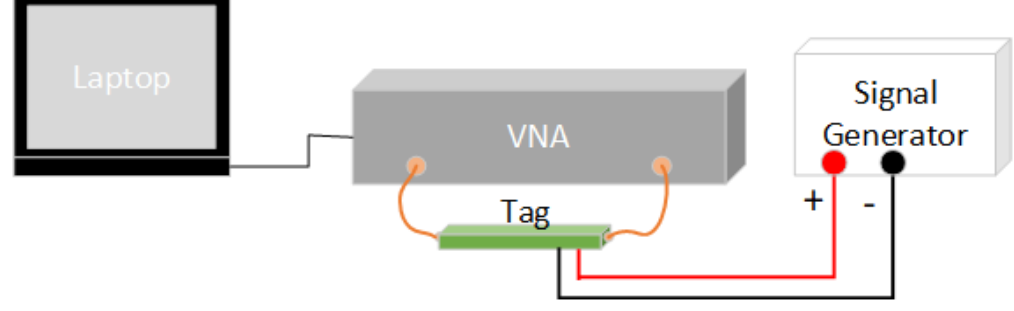
Figure 5. Test setup with signal generator.